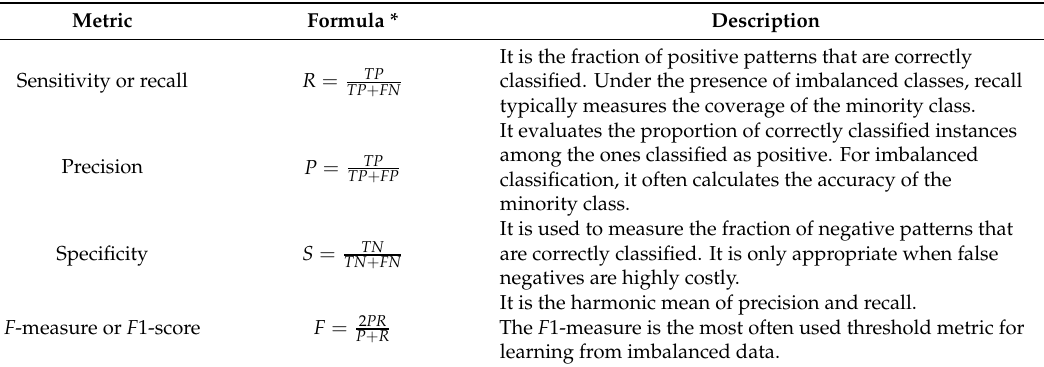
Table 1. Threshold metrics to evaluate the imbalanced classification task